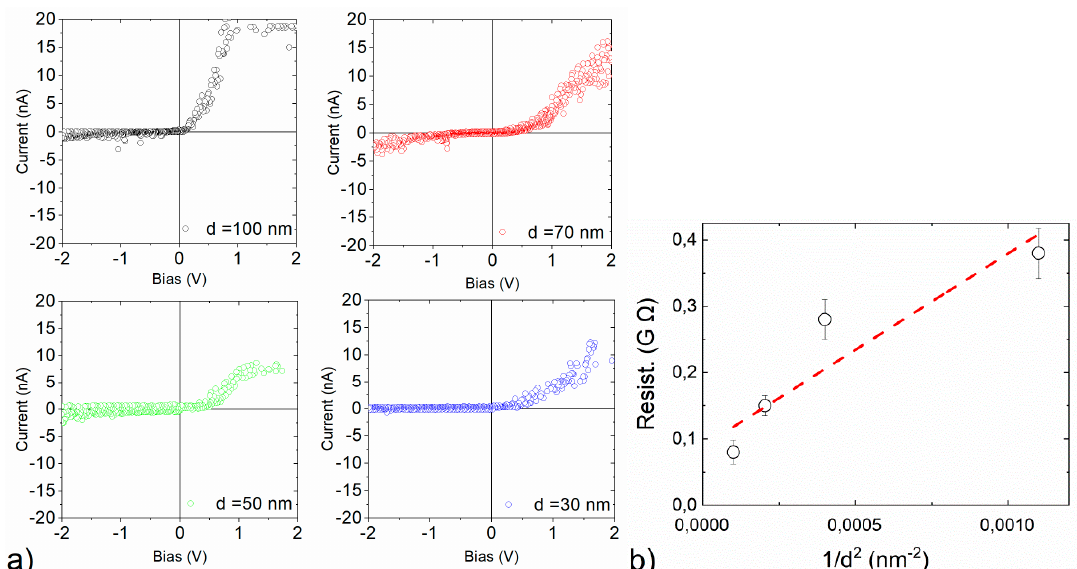
Figure 6. ( a ) I-V characterization of Si nano-pillars with di ff erent diameters (30–100 nm), ± 2 V bias sweep. Force was kept constant at 50 nN during the bias sweep. I-V shape recalls the behavior of a Schottky diode, as expected for a metal-semiconductor contact. ( b ) Resistance of the nano-pillars obtained from the measured current. The resistance is calculated from the derivate of the I / V curve in the linear part of the curve for positive voltage. We have introduced error bars to show the reproducibility of all measurements.